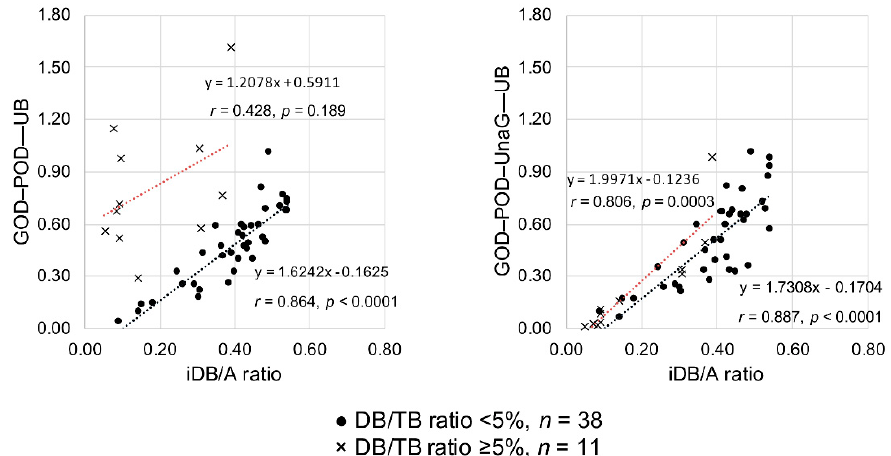
Figure 3. Correlations between the iDB / A ratio and serum UB values measured with the GOD–POD and GOD–POD–UnaG methods. A, albumin; DB, direct bilirubin; GOD, glucose oxidase; iDB, indirect bilirubin; POD, peroxidase; TB, total serum bilirubin; UB, unbound bilirubin; UnaG, bilirubin-inducible fluorescent protein from eel muscle.